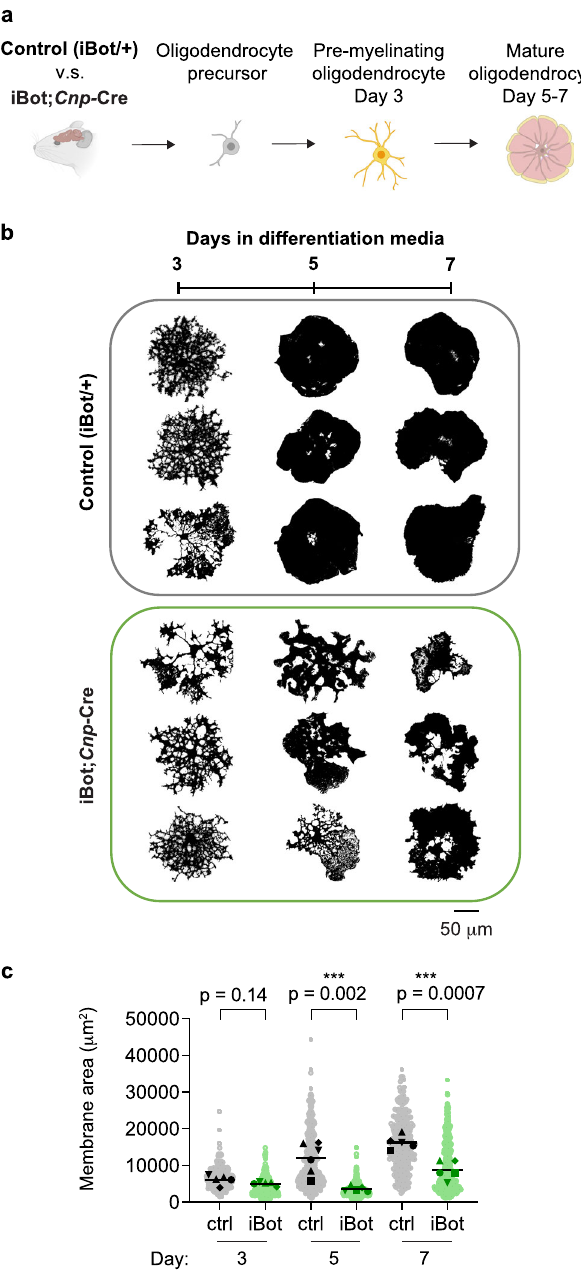
Fig. 3 | VAMP2/3-mediated exocytosis is required for oligodendrocyte mem- brane expansion. a Oligodendrocyte precursors puri fi ed from transgenic mouse brains (control vs. iBot; Cnp -Cre) and differentiated in culture to investigate cell- intrinsic effects of VAMP2/3 inactivation. Created with BioRender.com. b ThresholdedmasksofprimaryoligodendrocytesstainedforGalCerlipidduring a differentiation time course of 3, 5, and 7 days from control (top) and iBot; Cnp - Cre (bottom) mice to show cell morphologies. Scale bar, 50 μ m. See Supple- mentary Fig. 6e for examples of GalCer staining. Source data are provided in the Source Data fi le. c Quanti fi cation of membrane surface area marked by GalCer lipid, where each light-shaded point corresponds to a single cell, each dark- shaded point represents the mean area of cells from one biologically independent replicate, and the line represents the mean area from n =5 biologically independent replicates for each condition. See Supplementary Table 4 for descriptive statistics. Statistical measurements ( p -value) were determined by an unpaired, two-tailed t-test. Source data are provided in the Source Data fi